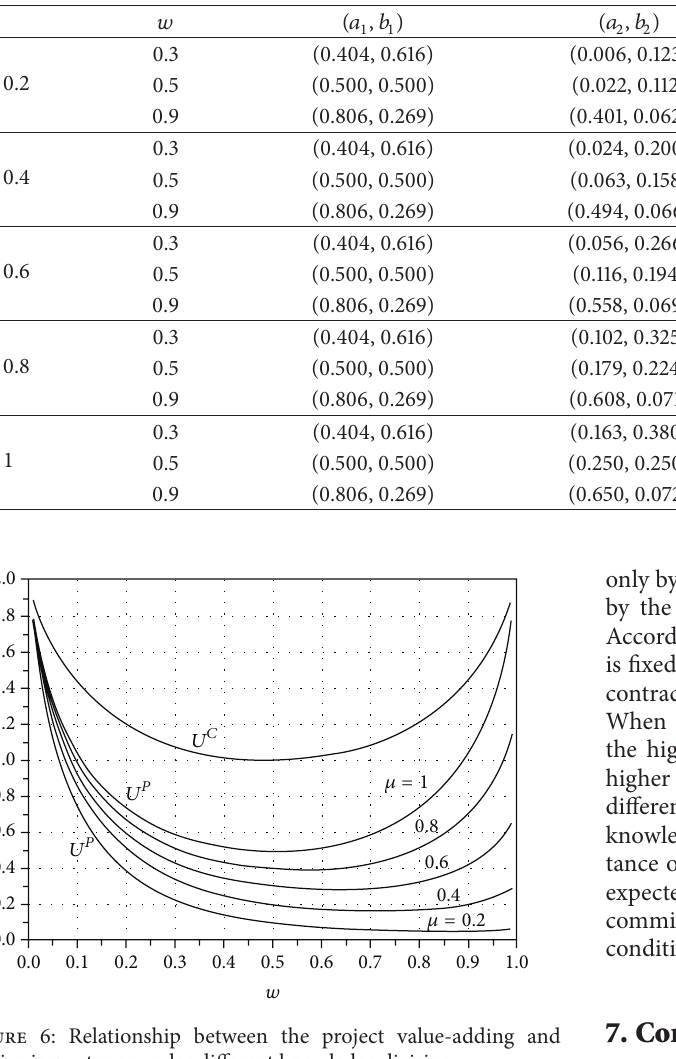
Figure 6: Relationship between the project value-adding and relative importance under different knowledge